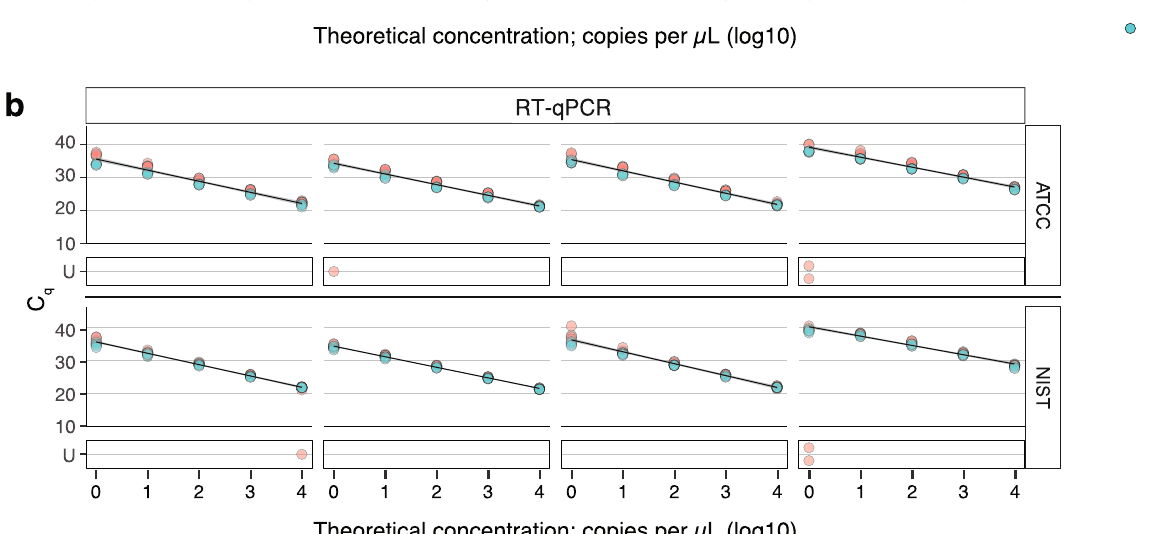
Data 1). Among these, we picked N1 as the target gene for the rest of this study (Supplementary Fig. 2a). Given the high degree of concordance across replicate ddPCR and RT-qPCR reactions, we averaged results from replicate reactions in subsequent experi- ments. Further, since ddPCR allows absolute quanti fi cation of viral loads with high sensitivity 22 , while RT-qPCR is a more accessible platform for nucleic acid detection, we employed both techniques across the study to be widely informative. In both assays, we used the one-step format that combines the reverse transcription and ampli fi cation steps in a single reaction for a simpler protocol.